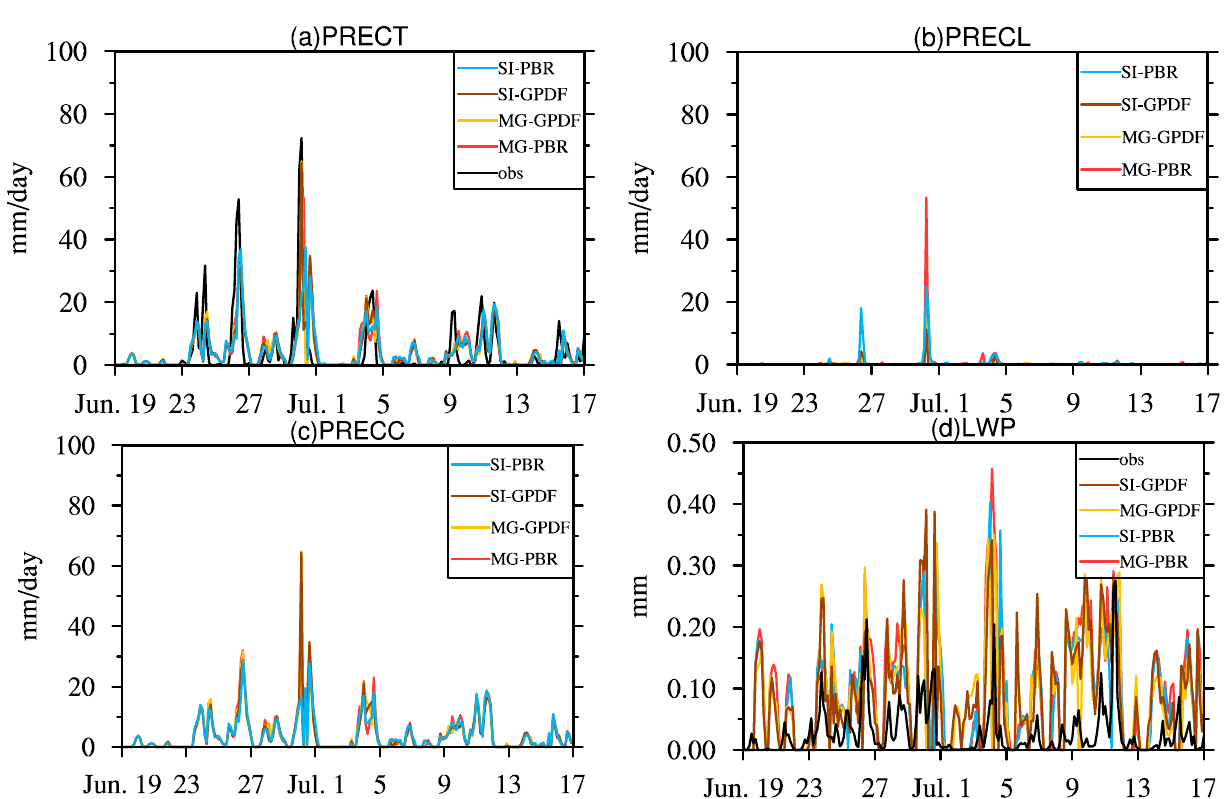
Figure 8. ( a ) Total precipitation rate, ( b ) large-scale precipitation rate, ( c ) convective precipitation rate and ( d ) liquid cloud water path in the simulations MG-PBR (red), SI-PBR (cyan), MG-GPDF (orange), and SI-GPDF (brown) compared to the observation (black).